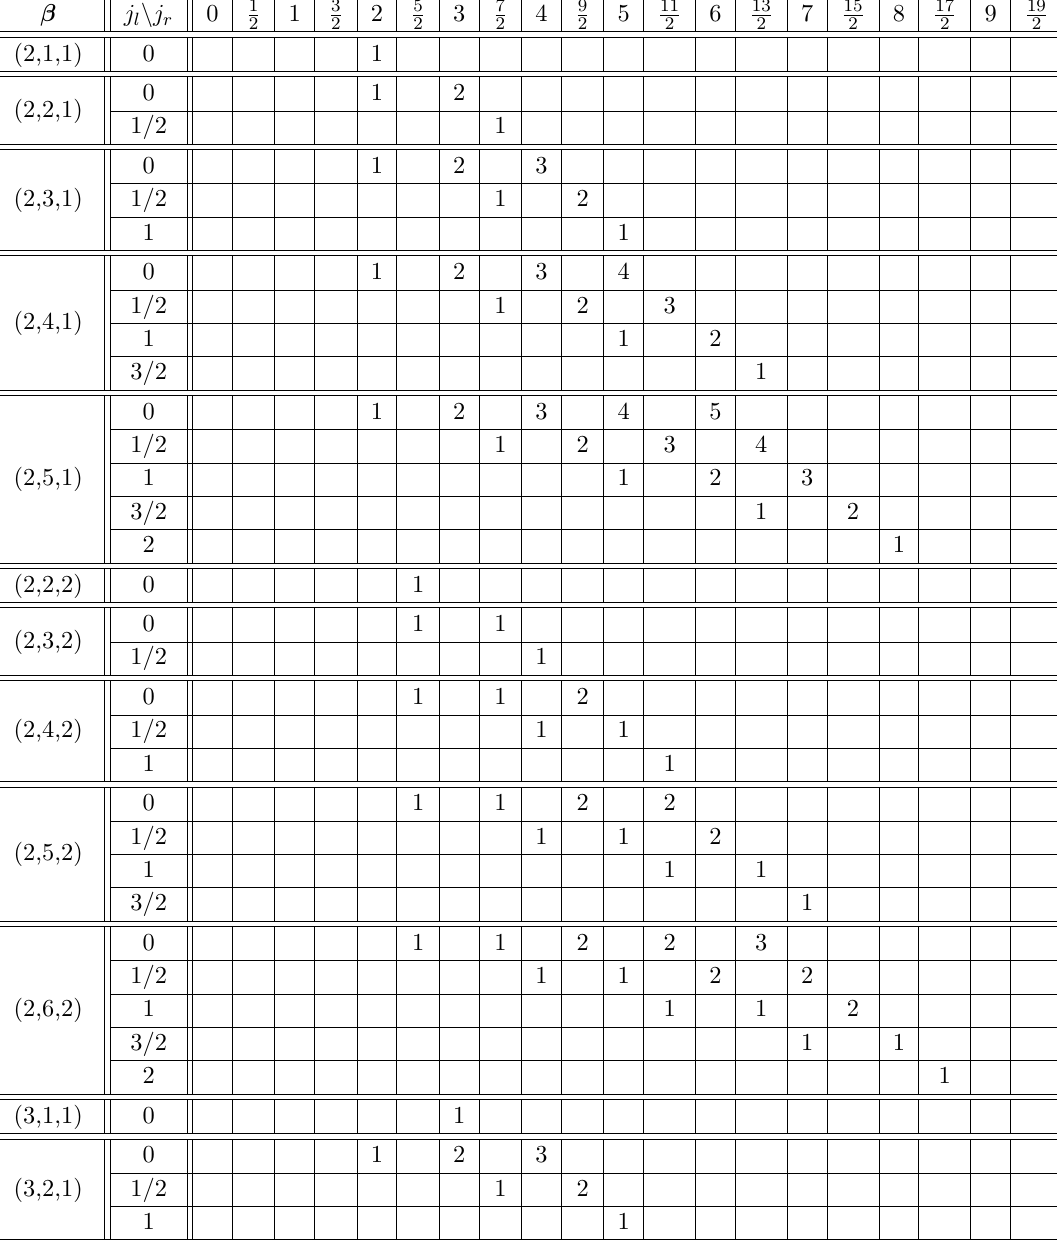
Table 2 . Refined GV invariants N β